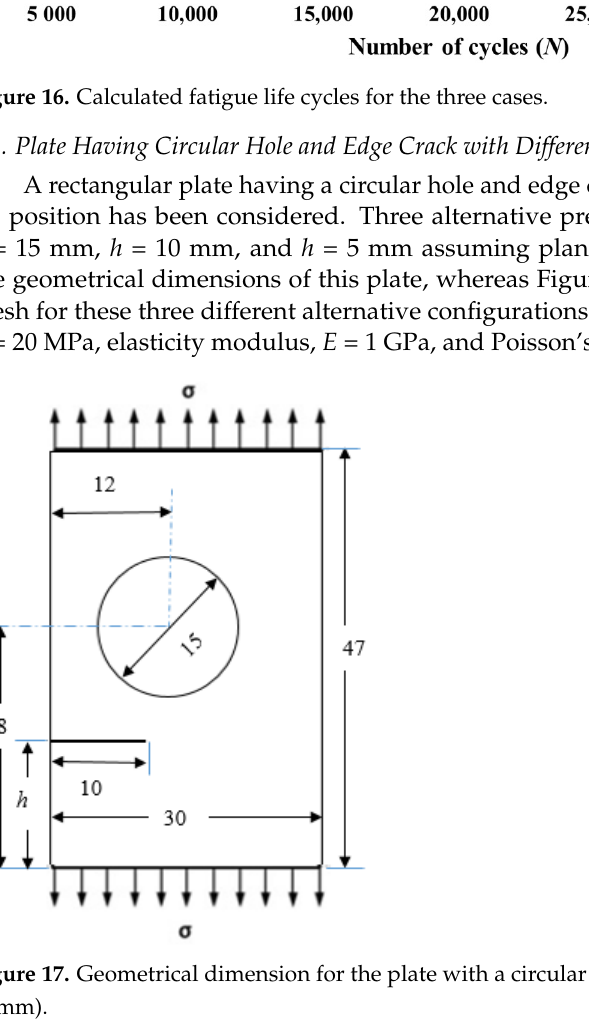
Figure 18. Initial adaptive mesh for the three different configurations of plates with a circular hole and edge crack. Mesh refinement is observed executed all over the crack tip and the hole before the crack propagates, and it tends to be carried out only near the crack tip as it grows until it eventually gets more remote from the hole. Figure 19a–c depicted the predicted crack growth trajectories for three different configurations of crack position, which were com- pared to the numerical results obtained by [52] with a locally refined (LR) B-splines ex- tended isogeometric analysis (XIGA) method, as shown in Figure 19d–f. Essentially, the